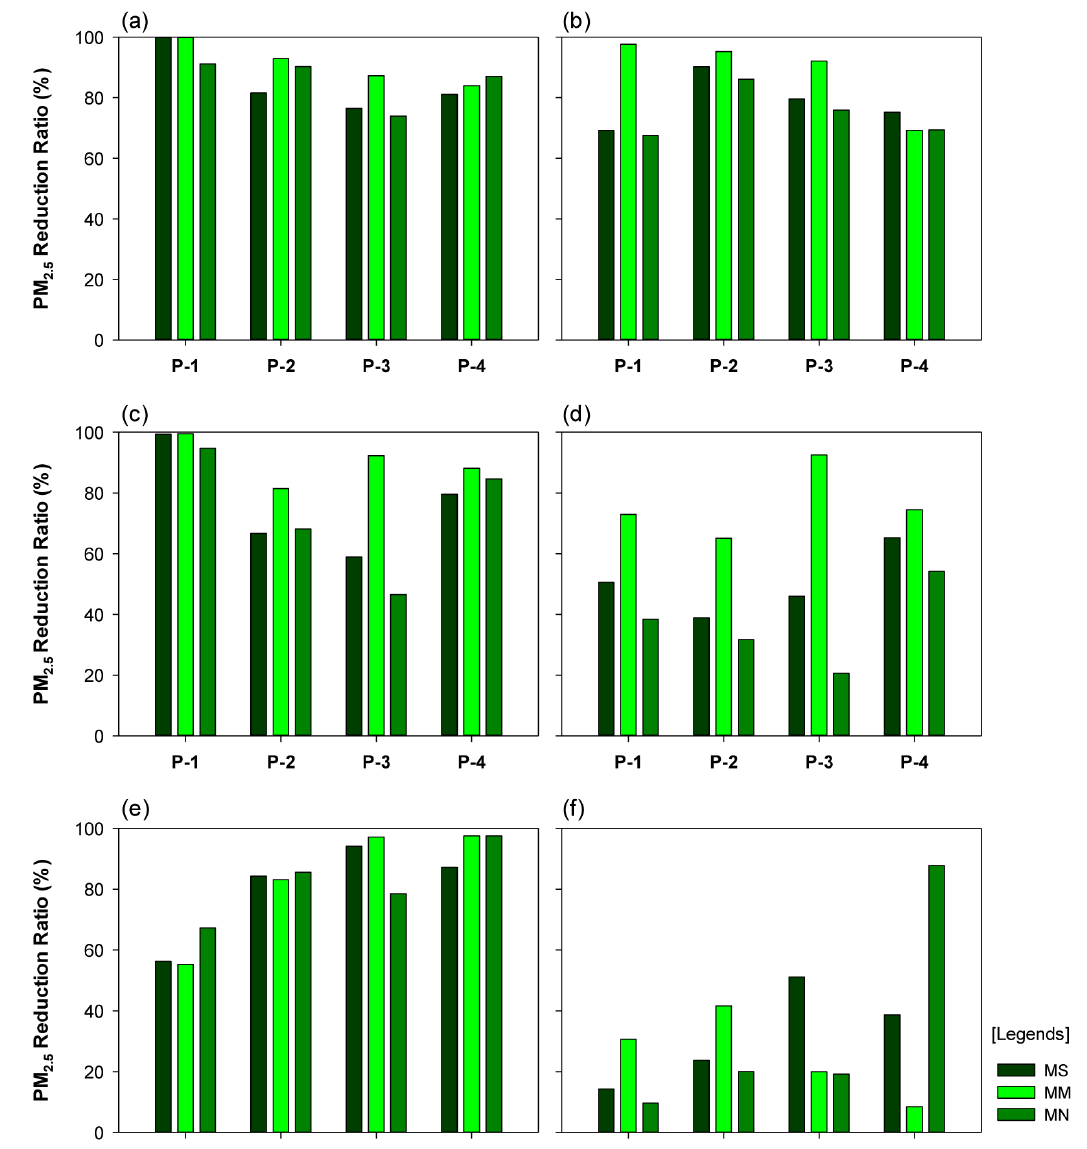
Figure 12. Graphs portraying the particulate matter (PM 2.5 ) reduction rate, based on the street tree and central reserve planting structures, for the scenario where the wind direction was vertical (0°): ( a ) wind velocity of 1 m/s, with street tree-multi-planting (SM), ( b ) wind velocity of 1 m/s, with street tree-single planting (SS), ( c ) wind velocity of 4 m/s, with SM, ( d ) wind velocity of 4 m/s, with SS, ( e ) wind velocity of 7 m/s, with SM, and ( f ) wind velocity of 7 m/s, with SS; for the models, please refer to Table 1.